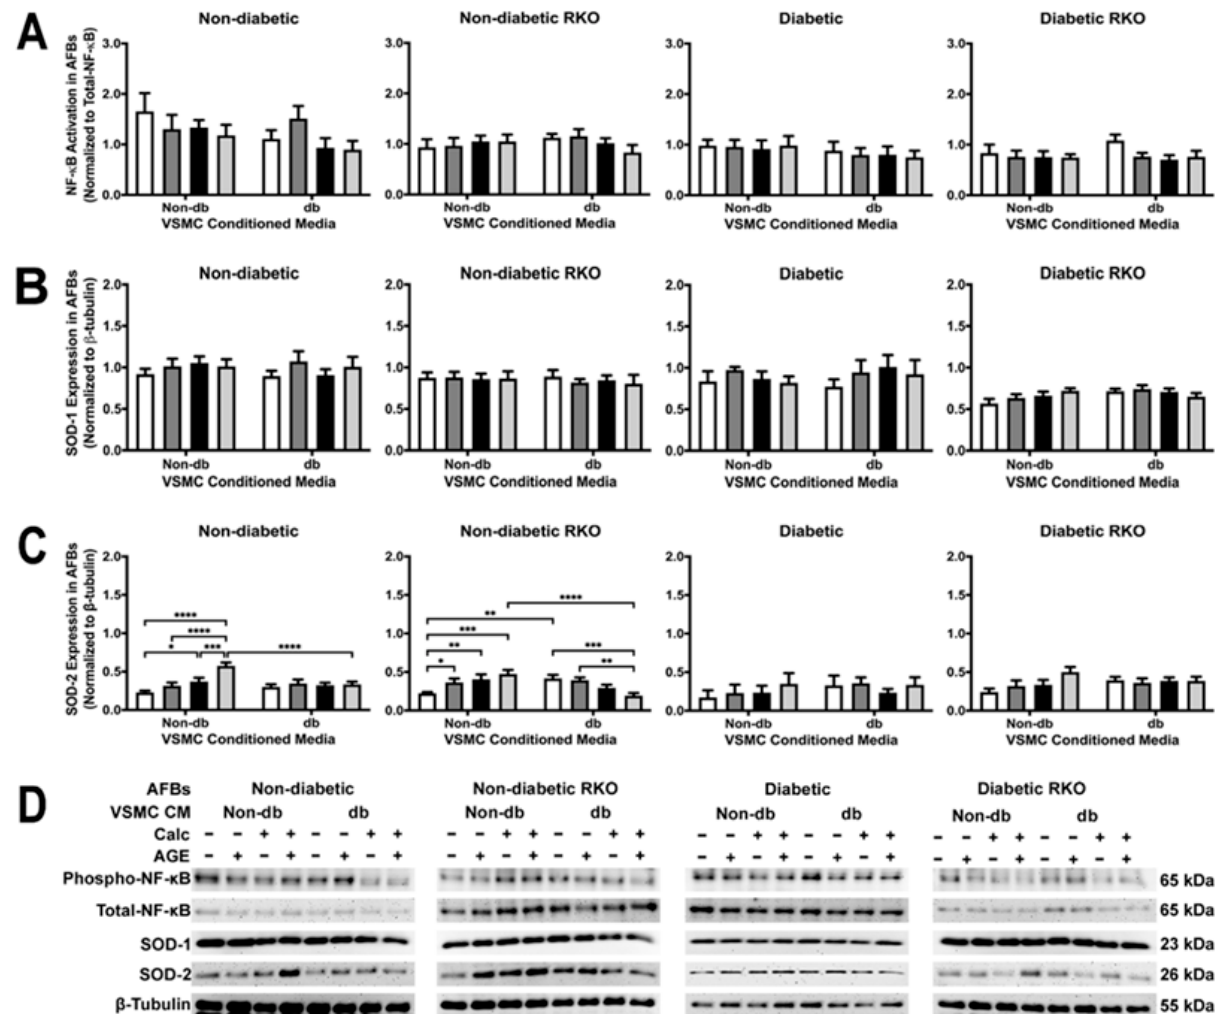
Figure 9. Calcified VSMC-conditioned media caused changes in SOD-2 expression in non-diabetic AFBs. Primary AFBs were isolated and treated with VSMCs-conditioned media at a 1:10 dilution in 2% FBS genotype appropriate DMEM for 7 days. Protein expression was quantified of p65 NF- κ B (65 kDa; ( A )), SOD-1 (23 kDa, ( B )), and SOD-2 (26 kDa, ( C )). All protein levels were normalized to β -tubulin ( D ) and graphed as mean ± SEM with n = 3–6 of independent replicates. A two-way